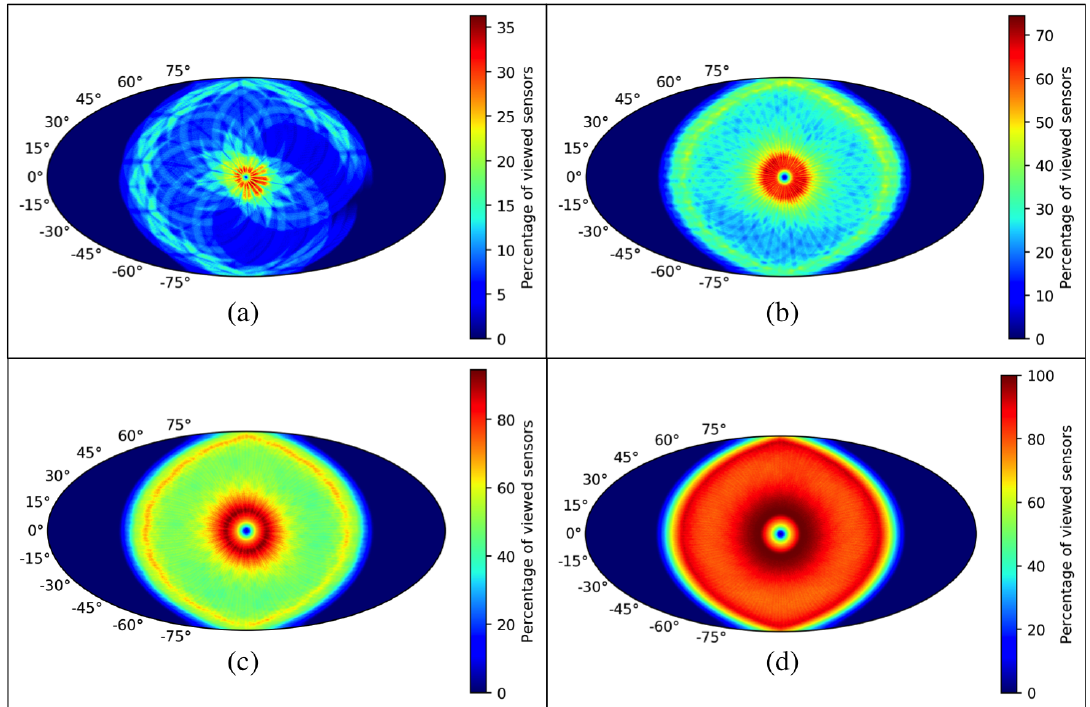
Figure 11. Percentage of viewed detectors according to the position of L2-CalSat relative to the CMB-Sat throughout 1.5 ( a ), 6 ( b ), 12 ( c ) and 24 h ( d